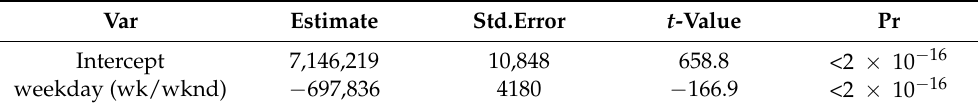
Table 2. Parametric coefficients for non-spatial GAM.